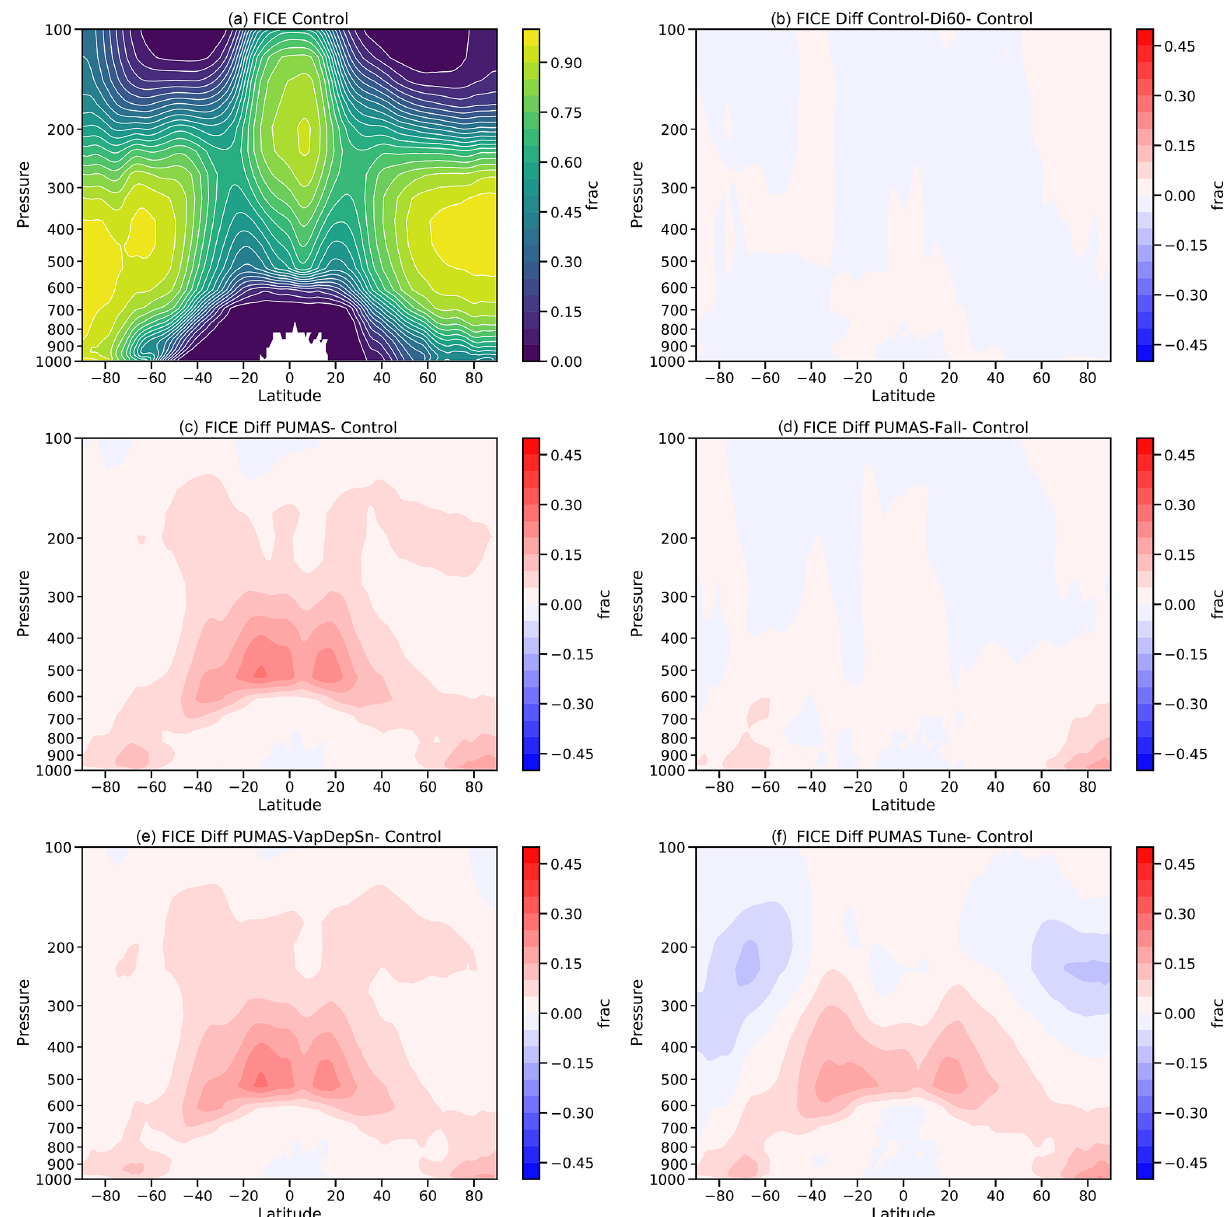
Figure 7. Zonal annual mean ice fraction for the (a) control (MG3) and differences in ice fraction for (b) Control-Di60 – control, (c) PUMAS – control, (d) PUMAS-Fall – control, (e) PUMAS-VapDepSn – control, and (f) PUMAS-Tune – control. Simulation names are defined